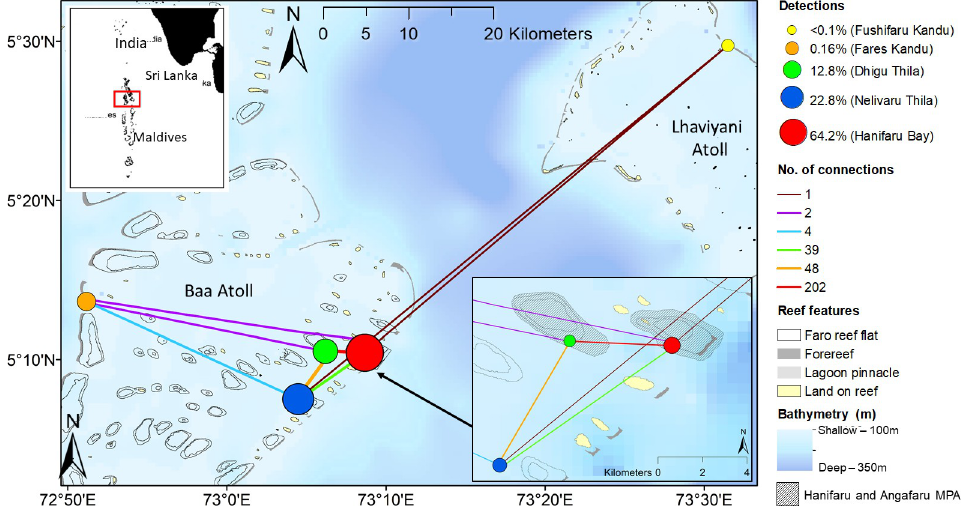
Fig 1. Mobula alfredi tag detections and acoustic receiver network map. Percentage of detections at each site corresponds to the colour and size of the node at each location. The network map showing how many times individuals were subsequently detected by each pair of acoustic receivers which corresponds to the colour and thickness of the line connecting the nodes. Map created in ArcGIS 10.7 (www.esri.com/) using bathymetry from GEBCO Compilation Group (2020) GEBCO 2020 Grid (doi:10.5285/a29c5465-b138-234d-e053-6c86abc040b9) and reef features from Millennium Coral Reef Mapping Project (MCRMP) (https://data.unep-wcmc.org/datasets/1); MCRMP validated maps provided by the Institute for Marine Remote Sensing, University of South Florida (IMaRS/USF) and Institut de Recherche pour le De´veloppement (IRD, Centre de Noume´a), with support from NASA. MCRMP unvalidated maps provided by IMaRS, USF with support from NASA and further interpreted by UNEP World Conservation Monitoring Centre (www.unep-wcmc.org). IRD, do not endorse these products. Inset top left: the Maldives Archipelago with the study area highlighted in the red box. Inset bottom right: close-up of the key habitats (Hanifaru Bay, Nelivaru Thila and Dhigu Thila) and the Hanifaru and Angafaru marine protected areas (MPAs).